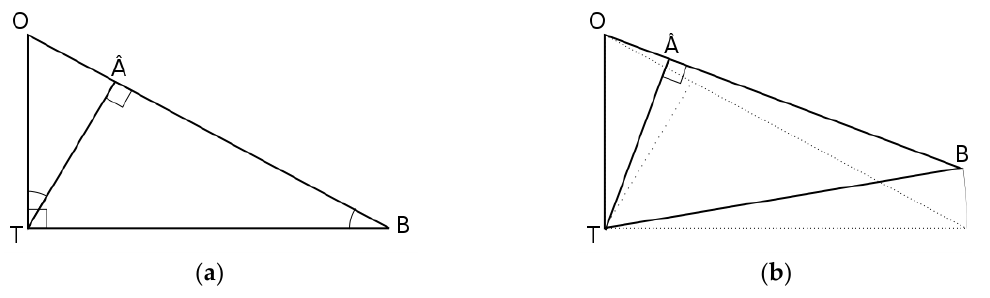
Figure 6. Geometrical representation of the analysis. ( a ) for observation errors uncorrelated with the background error. ( b ) with correlated errors. T indicate the truth, O the observation, B the background and A the optimal analysis.